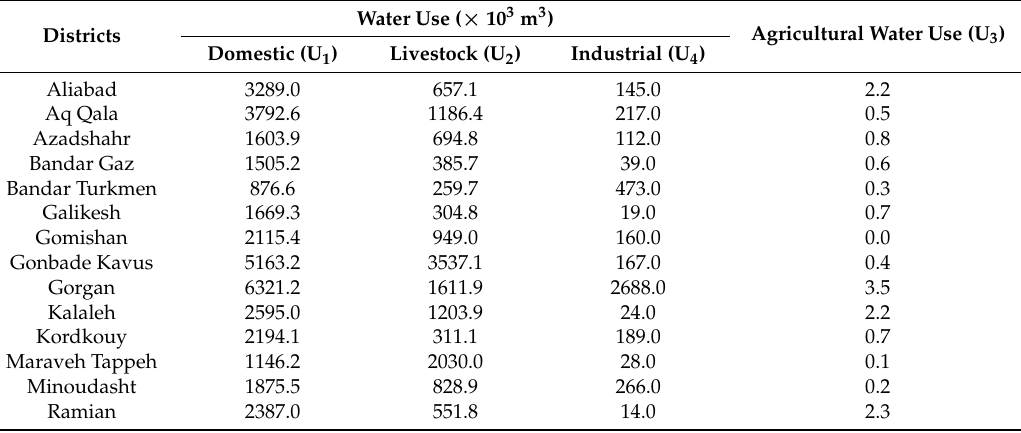
Table 6. The status of the “Use” component in different districts of Golestan Province.